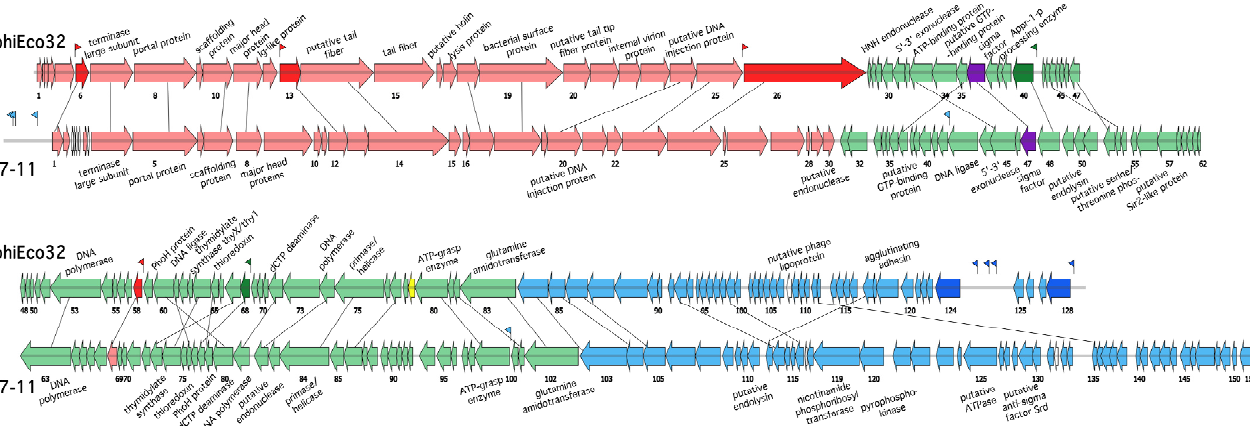
Figure 1. Comparison of phiEco32 and 7-11 genomes. The genomes of phages phiEco32 (NC_010324) and 7-11 (NC_015938) are schematically presented. Arrows represent annotated genes; the direction of an arrow indicates the direction of transcription. The ORFs are colored according to experimentally determined temporal classes of phiEco32: blue—early genes, green—middle genes and red—late genes. Dark shaded colors indicate phiEco32 genes, in front of which promoters were located experimentally (shown as appropriately colored flags). ORFs’ encoding transcription factors are colored violet (sigma factors) and yellow (inhibitor of σ 70 transcription phi32_gp79). Homologous genes in the two genomes are connected by lines. For 7-11, bioinformatically predicted σ 70 promoters are indicated with colors matching expected gene expression classes.